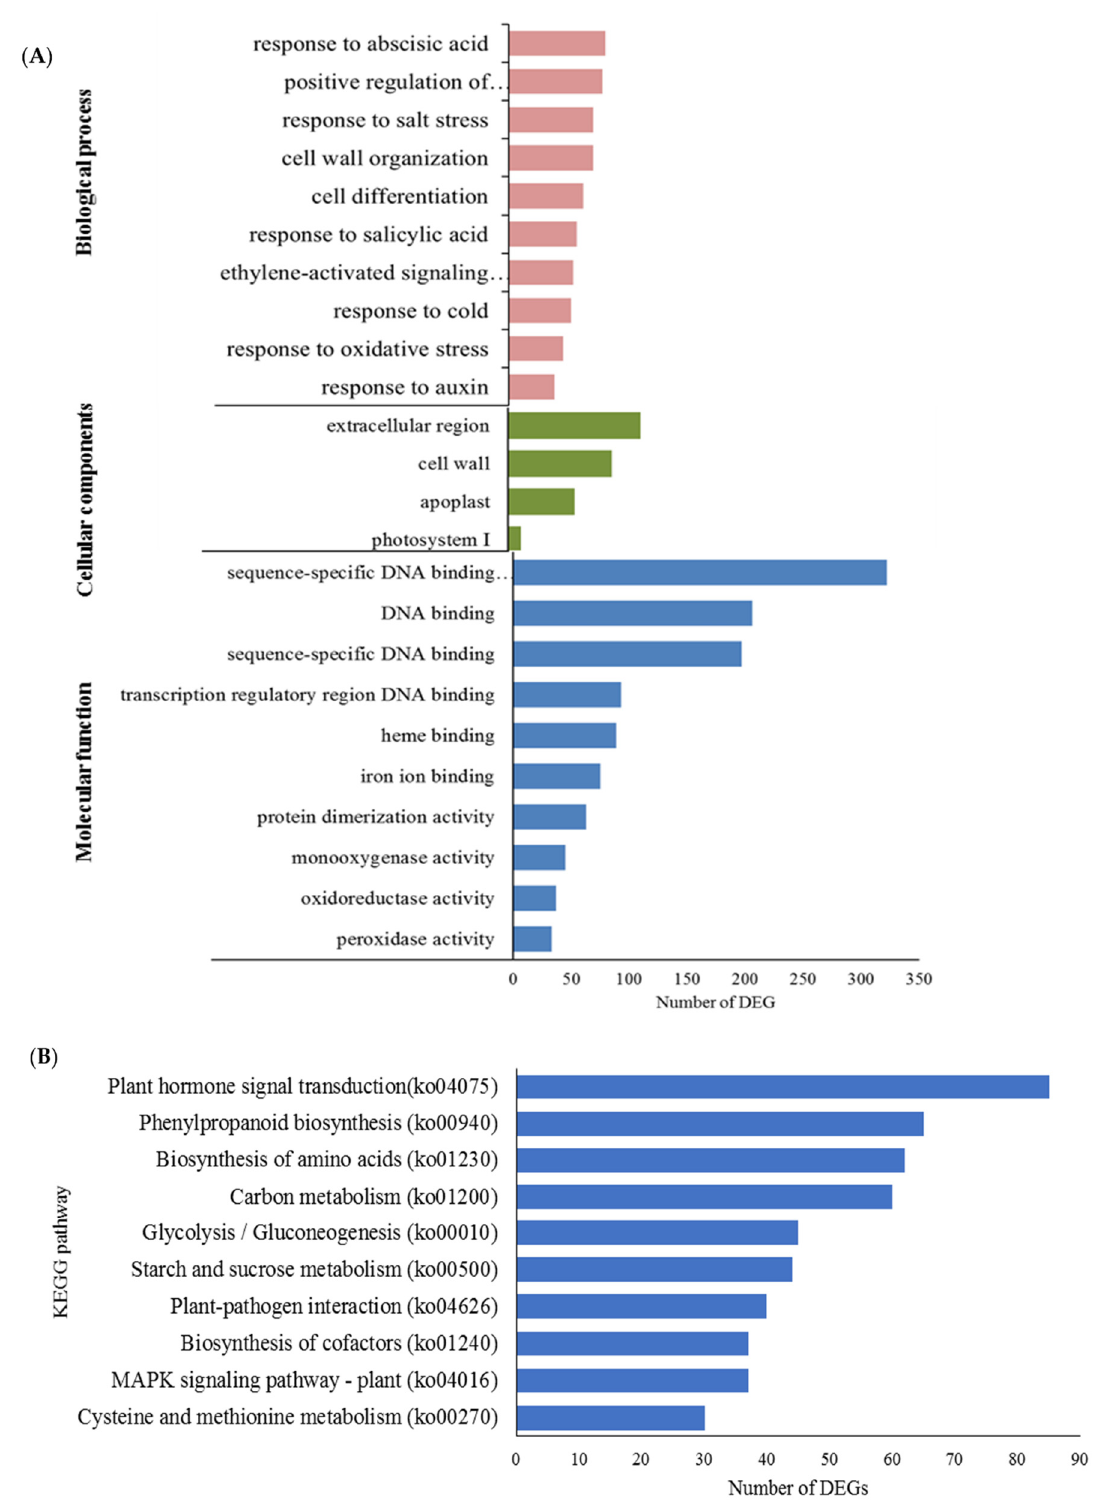
Figure 6. Functional categorization and enrichment of differentially changed genes between well- watered and waterlogged banana root samples. ( A ) Gene ontology enrichment according to biological processes, molecular functions, and cellular components and ( B ) the top ten significantly enriched KEGG pathways based on functional category.